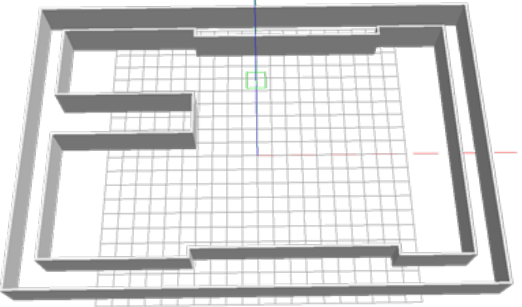
Figure 3. Gazebo simulation model of indoor corridor environment.